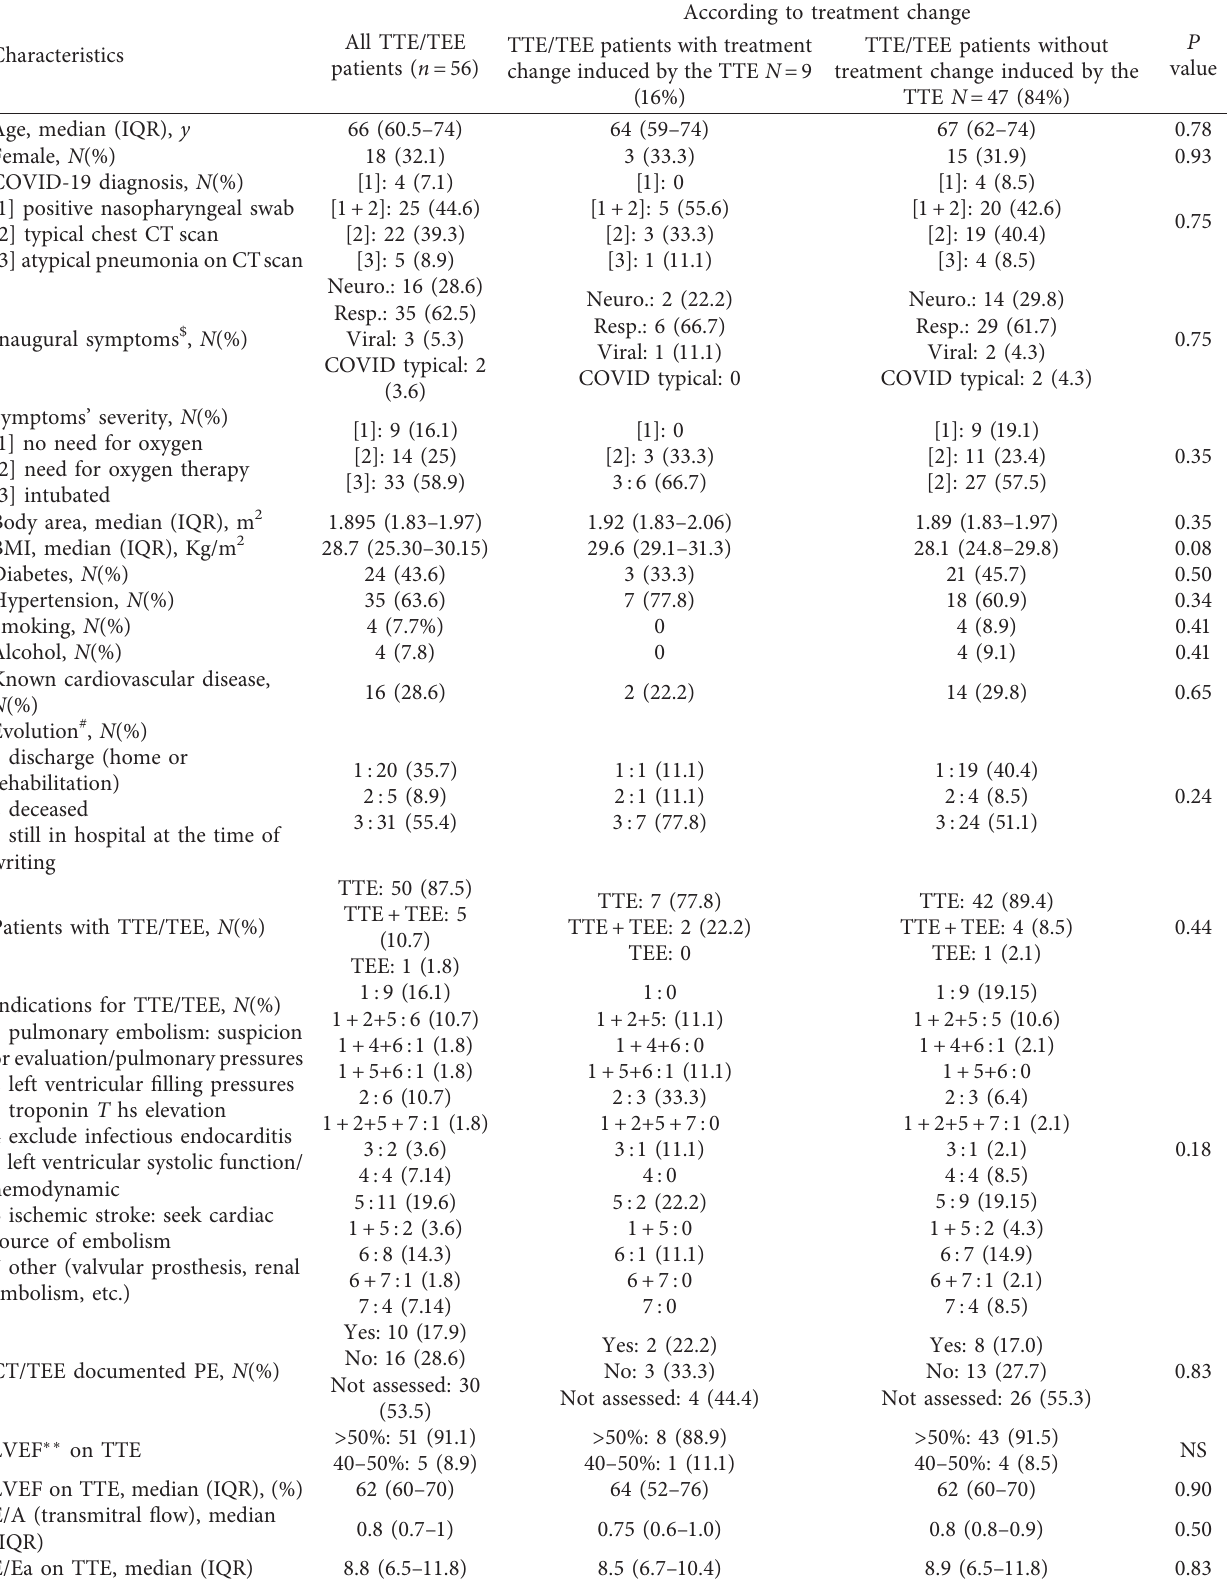
Table 1: Clinical and imaging characteristics of the patients